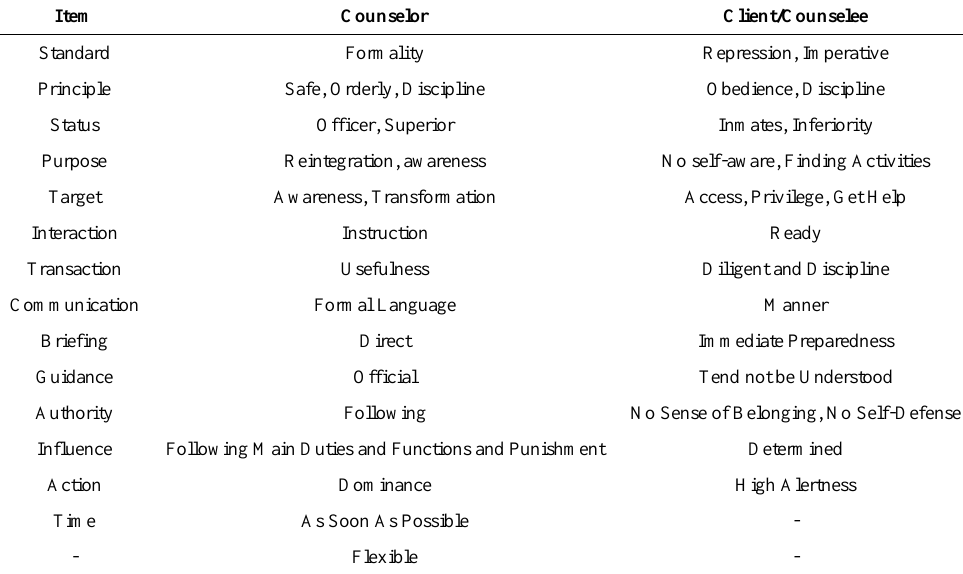
Table 3. Outline of Patronage